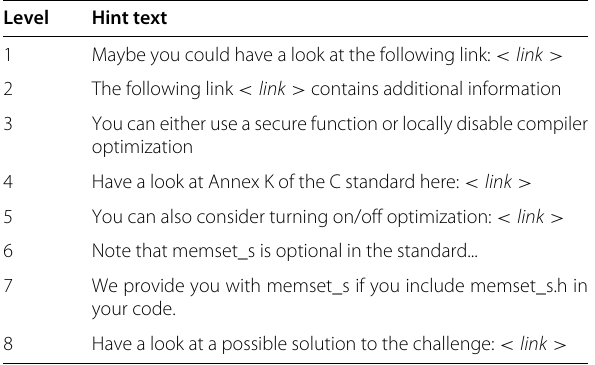
The chosen hint H n + 1 depends on the ladder and on the previous hint level sent to the participant on the ladder, as given by the system state. If there are no more hints in the ladder, no additional hint is sent to the